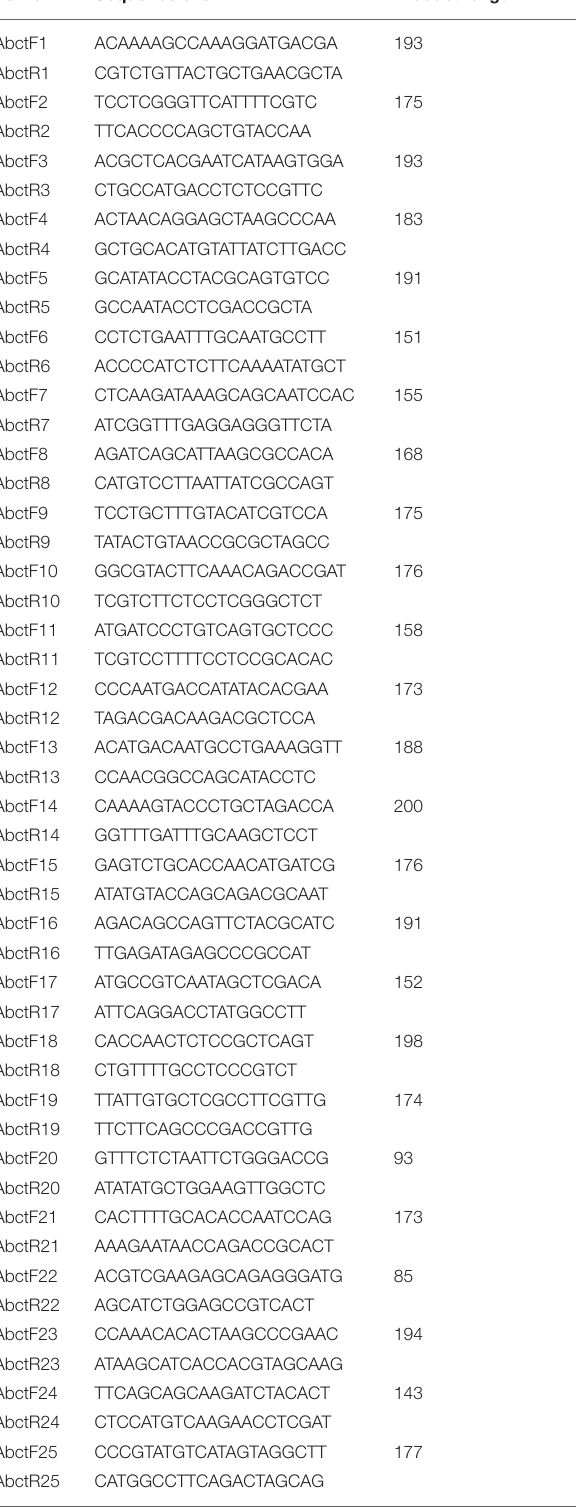
TABLE 1 | Primers for all ABC transporter genes in M. ruber M7 and used in the construction of deletion cassettes for the gene abct